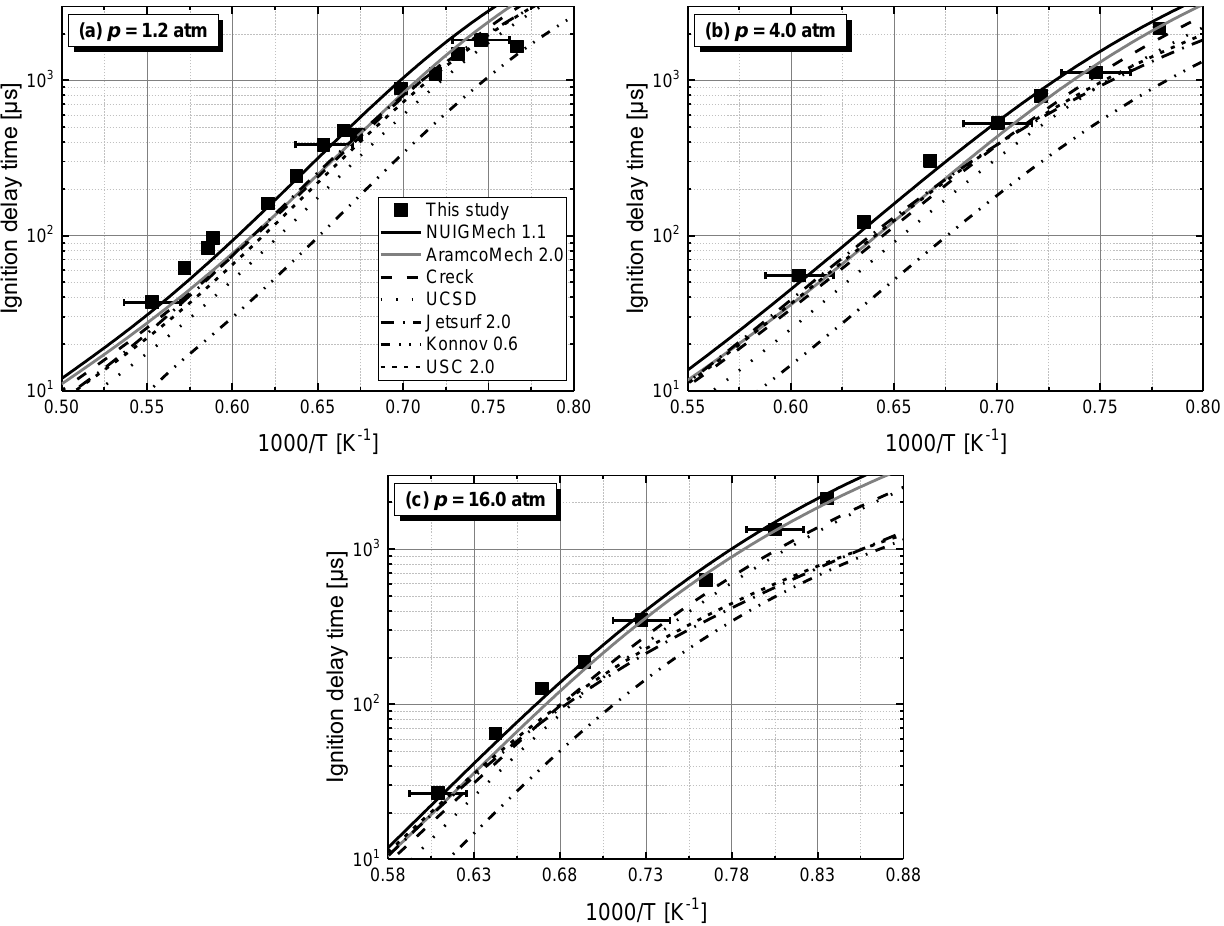
Figure 7. Comparison of measured and simulated IDTs of propene with shock tube at 1.2 atm ( a ), 4.0 atm ( b ) and 16.0 atm ( c ). Symbols: experiments in this study, lines: model simulations.